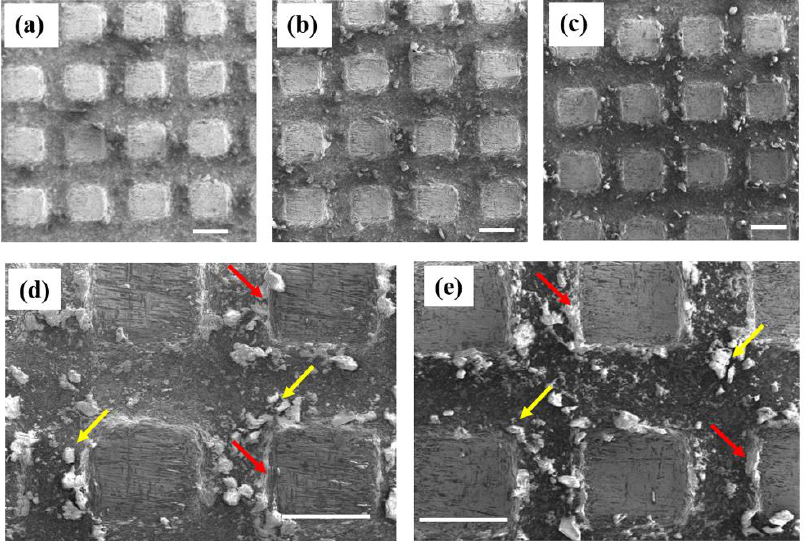
Figure 5. Tafel plots of the flat surface [1] and micropillar surface (MP).